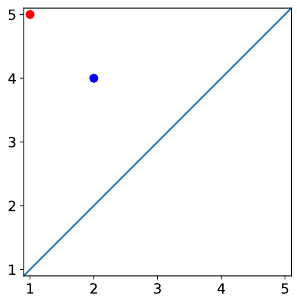
Figure 2. The persistence diagram corresponding to the example of tracking objects in a graph of Figure 1 is displayed. Each point in the persistence diagrams has a colour equal to that of the object to which it